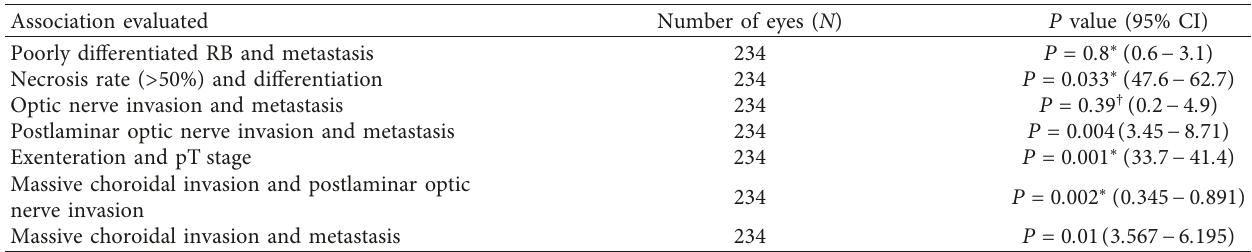
Figure 4: Pathologic TNM staging of the patients with retinoblastoma tumour. Table 4: Association of clinicopathological variables evaluated in the study ( n � 234